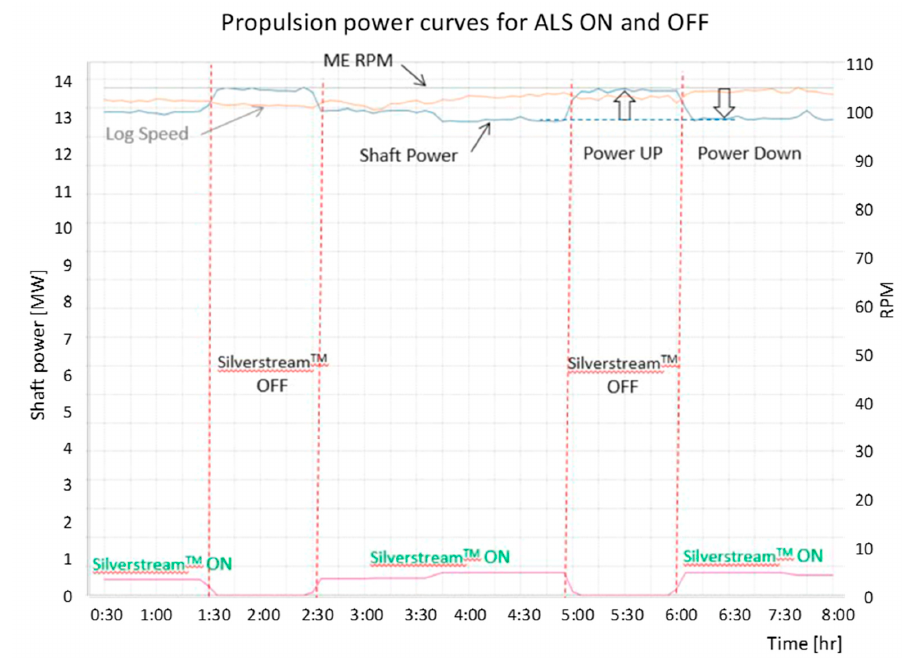
Figure 6. Example of Air Lubrication Effect from Monitoring System on MT Amalienborg [26]. Using the operating parameters of the propulsion system during the sea test of the ALS system the power consumption curve as a function of ship speed (propeller curve) were prepared, shown in Figure 7.